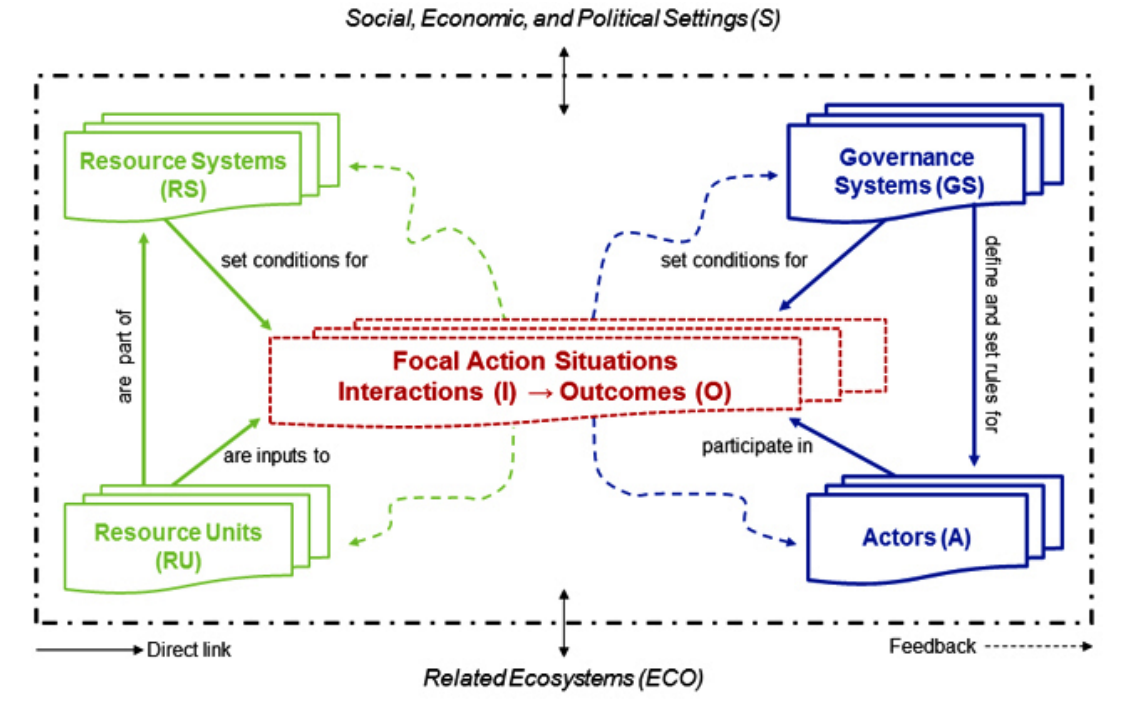
Fig. 2. Revised social-ecological system (SES) framework with multiple first-tier components. Solid boxes denote first-tier categories. Resource Systems, Resource Units, Governance Systems, and Actors are the highest-tier variables that contain multiple variables at the second tier as well as lower tiers (see Table 1 for an updated list of second-tier variables within each of the top-tier categories). Action Situations are where all the action takes place as inputs are transformed by the actions of multiple actors into outcomes. Dashed arrows denote feedback from action situations to each of the top-tier categories. The dotted-and-dashed line that surrounds the interior elements of the figure indicates that the focal SES can be considered as a logical whole, but that exogenous influences from related ecological systems or social-economic-political settings can affect any component of the SES. These exogenous influences might emerge from the dynamic operation of processes at larger or smaller scales than that of the focal